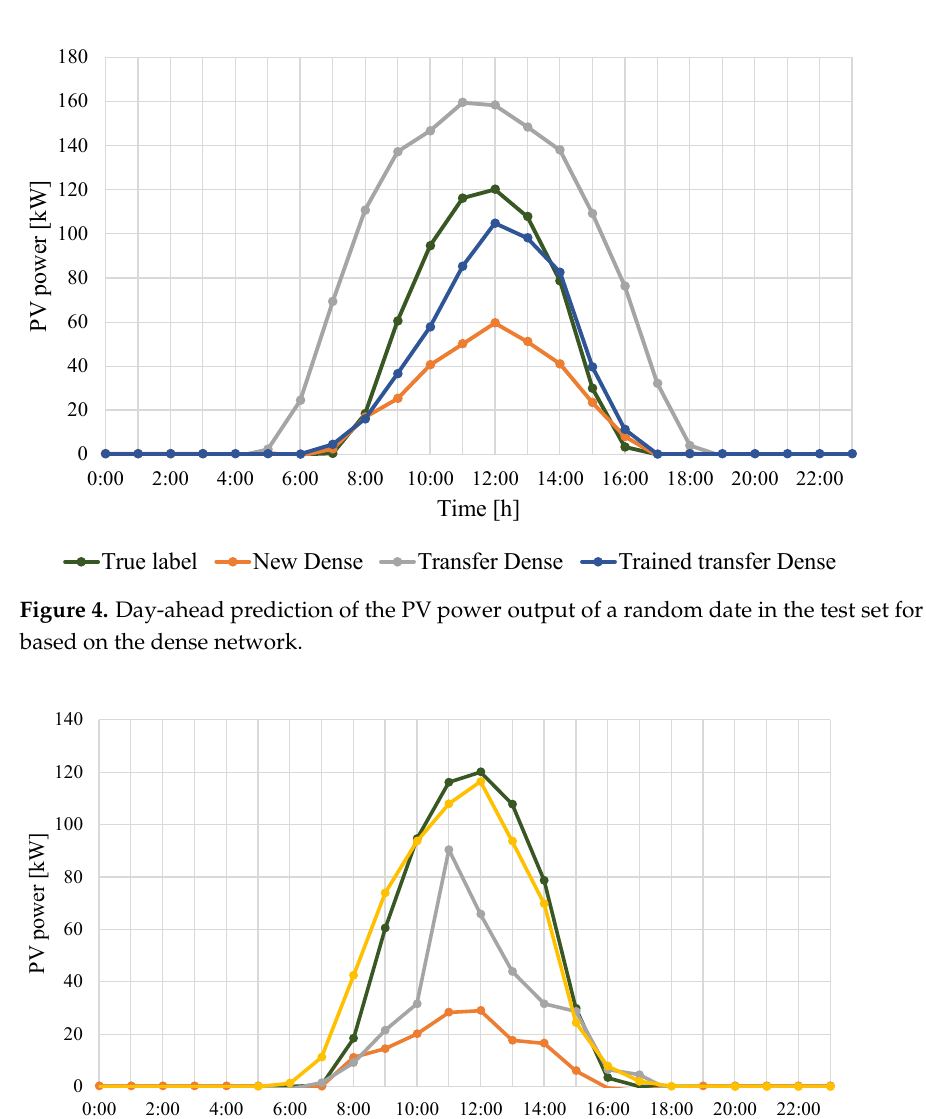
223 Figure 3. The accuracy of the three sets of models presented in terms of MAE [kW] on the test set of db 2. To thoroughly evaluate the top-performing models, this figure focuses on a close examination of the results obtained from the dense, CNN, and LSTM models. The zoomed-in chart offers a clear and concise comparison of the performance of each model. Figure 4 illustrates an hourly day-ahead PV power prediction of a random date in the test set of db 2 based on the dense model. The new dense model failed to predict the